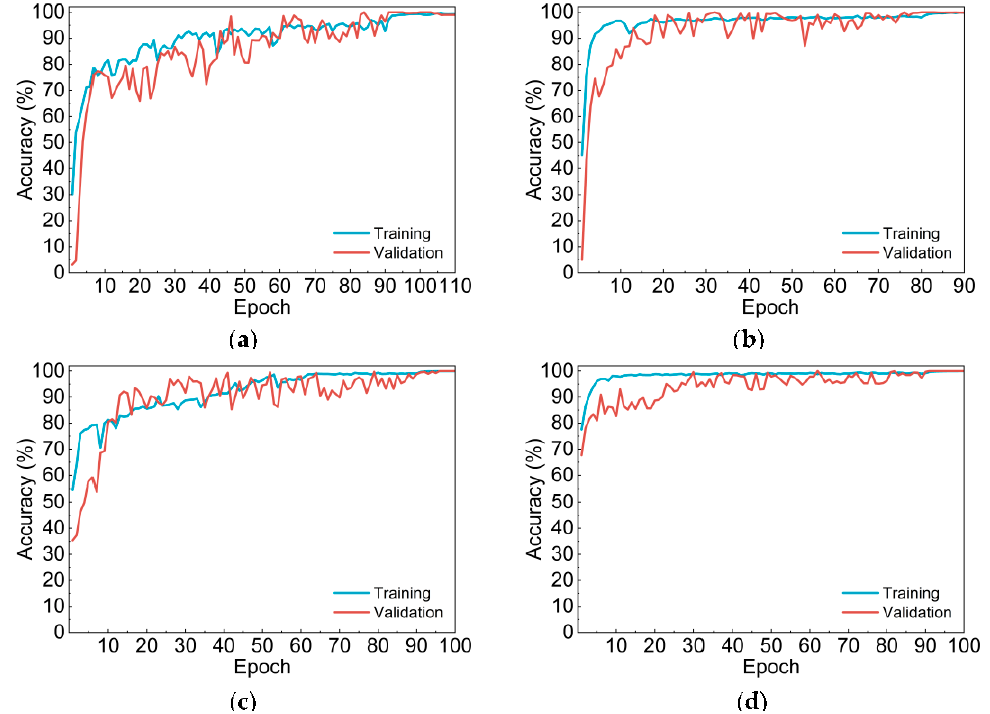
Figure 3. Accuracy curves of four convolutional neural network (CNN) models. ( a ) Net-I; ( b ) Net-II; ( c ) Net-III; ( d ) Net-IV.